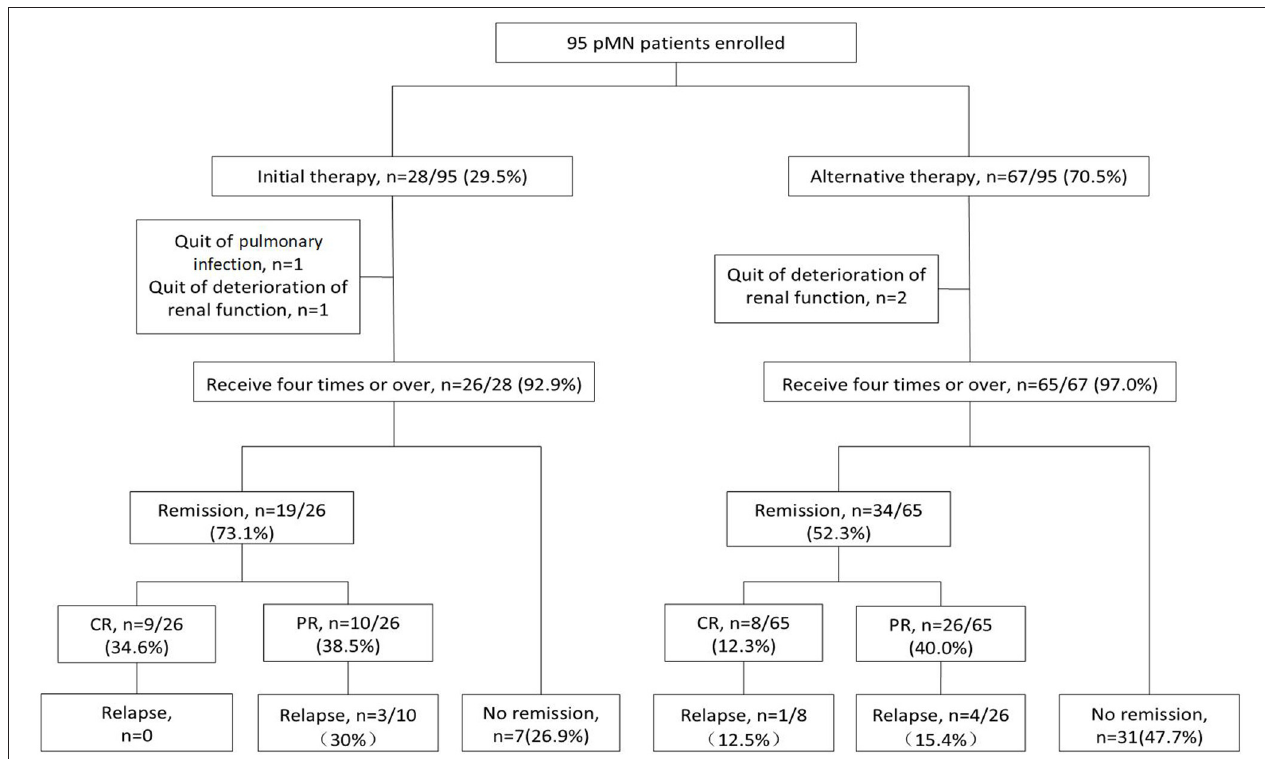
FIGURE 1 | Flow chart of the patients with pMN receiving rituximab therapy. There were 95 PMN patients enrolled, with 28 patients received rituximab as initial therapy and 67 as alternative therapy. There were 91 (95.8%) patients who accomplish the first administration of four times weekly usage and the remaining 4 (4.21%) patients did not. One patient discontinued treatment due to severe pulmonary infection, and three patients progressed into ESRD before the fourth infusion of rituximab. The remission rate was 73.1% (34.6% CR and 38.5% PR) in initial group and 52.3% (12.3% CR and 40.0% PR) in alternative group. 3/10 (30%) PR patients relapsed in initial group. 1/8 (12.5%) CR patients and 4/26 (15.4%) PR patients relapsed in alternative group. CR, complete remission; PR, partial